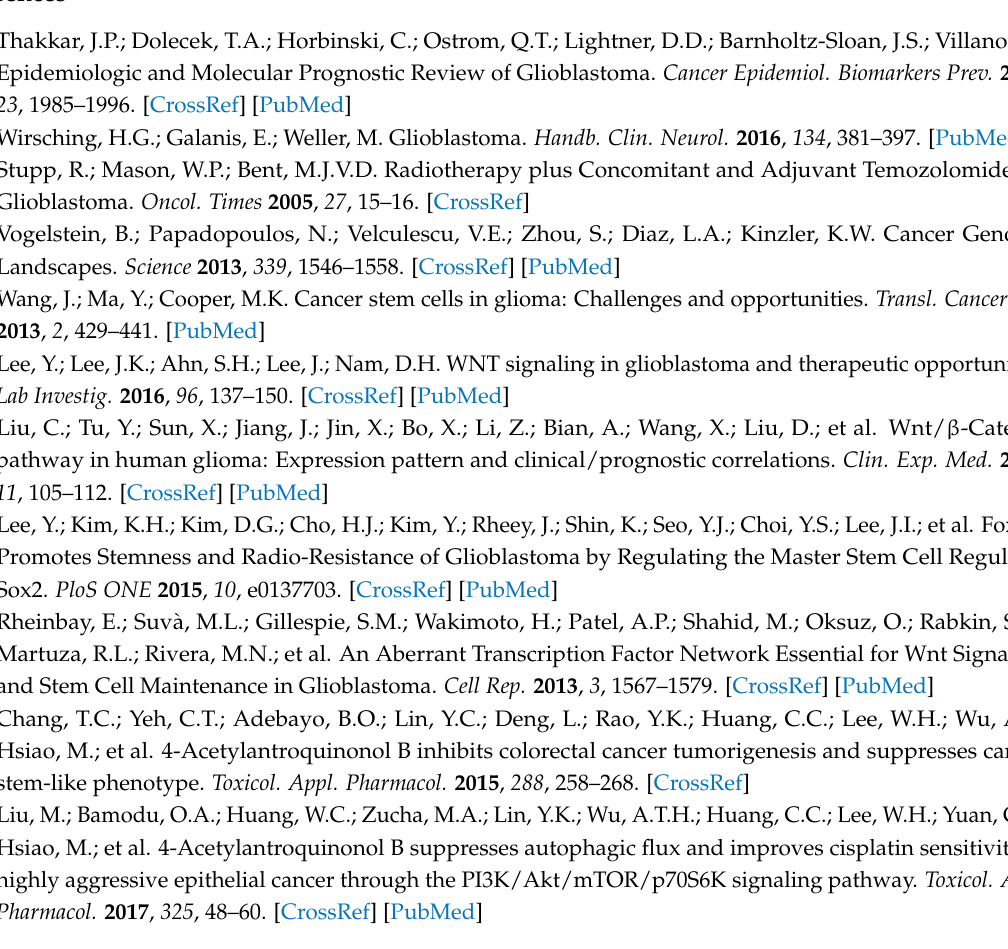
Figure S1: Aberrant expression of β -catenin is characteristic of GBM and correlates with poor